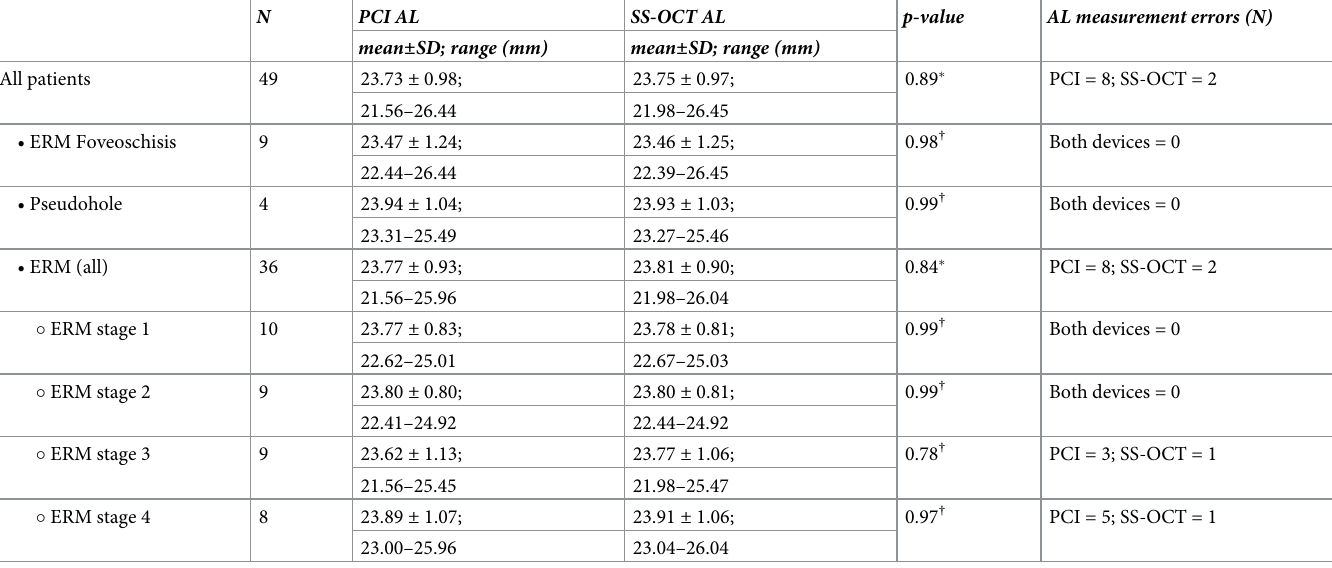
Table 1. Mean axial length values from the two devices in the overall cohort and subgroups and statistical analysis. N PCI AL